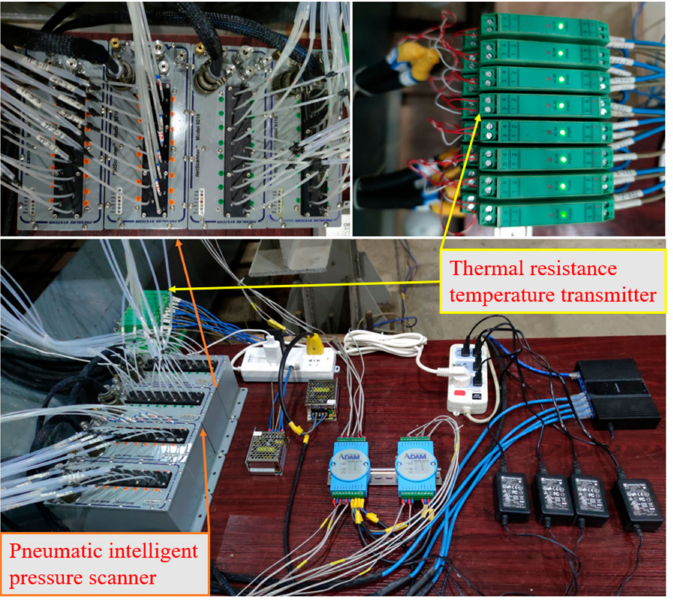
Figure 4. Measuring equipment of IBC.